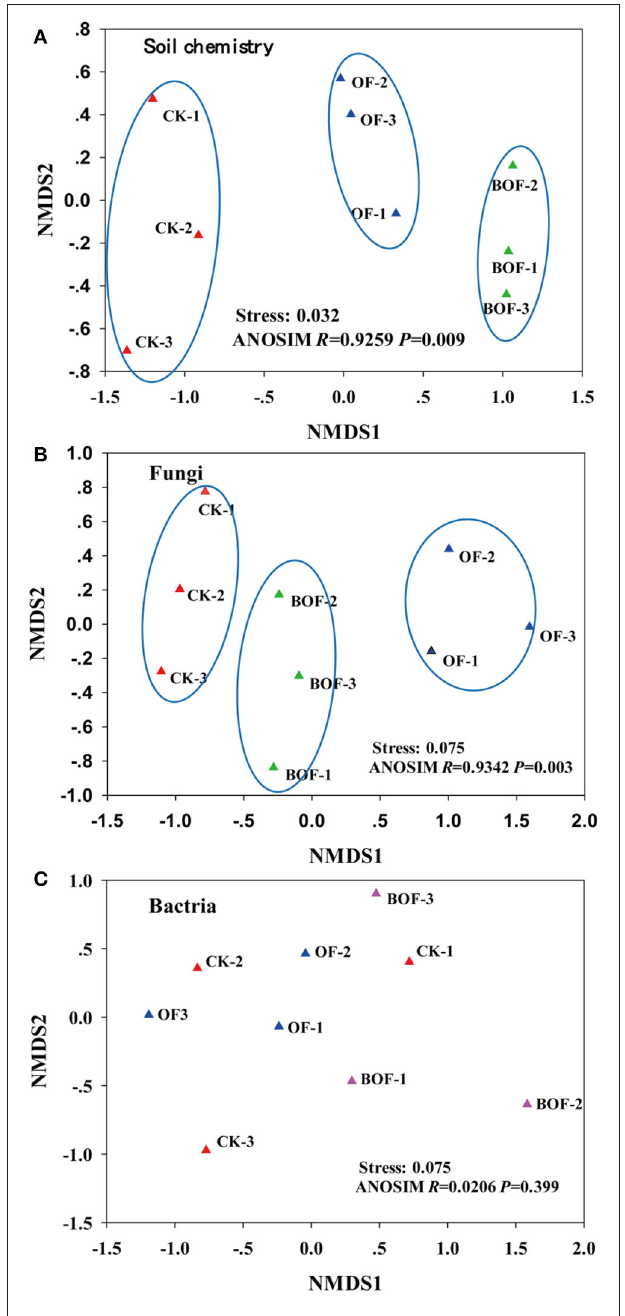
FIGURE 2 | The first two non-metric multidimensional scaling (NMDS) axes of (A) soil chemistry community, (B) fungal community and (C) bacterial community. CK, non-amended; OF: 9,000kg ha − 1 organic fertilizer (composted cattle manure); BOF, 9,000kg ha − 1 biofertilizer (composted cattle manure + Trichoderma inoculum). Each treatment had three replications (CK-1, CK-2, CK-3; OF-1, OF-2, OF-3; BOF-1, BOF-2,